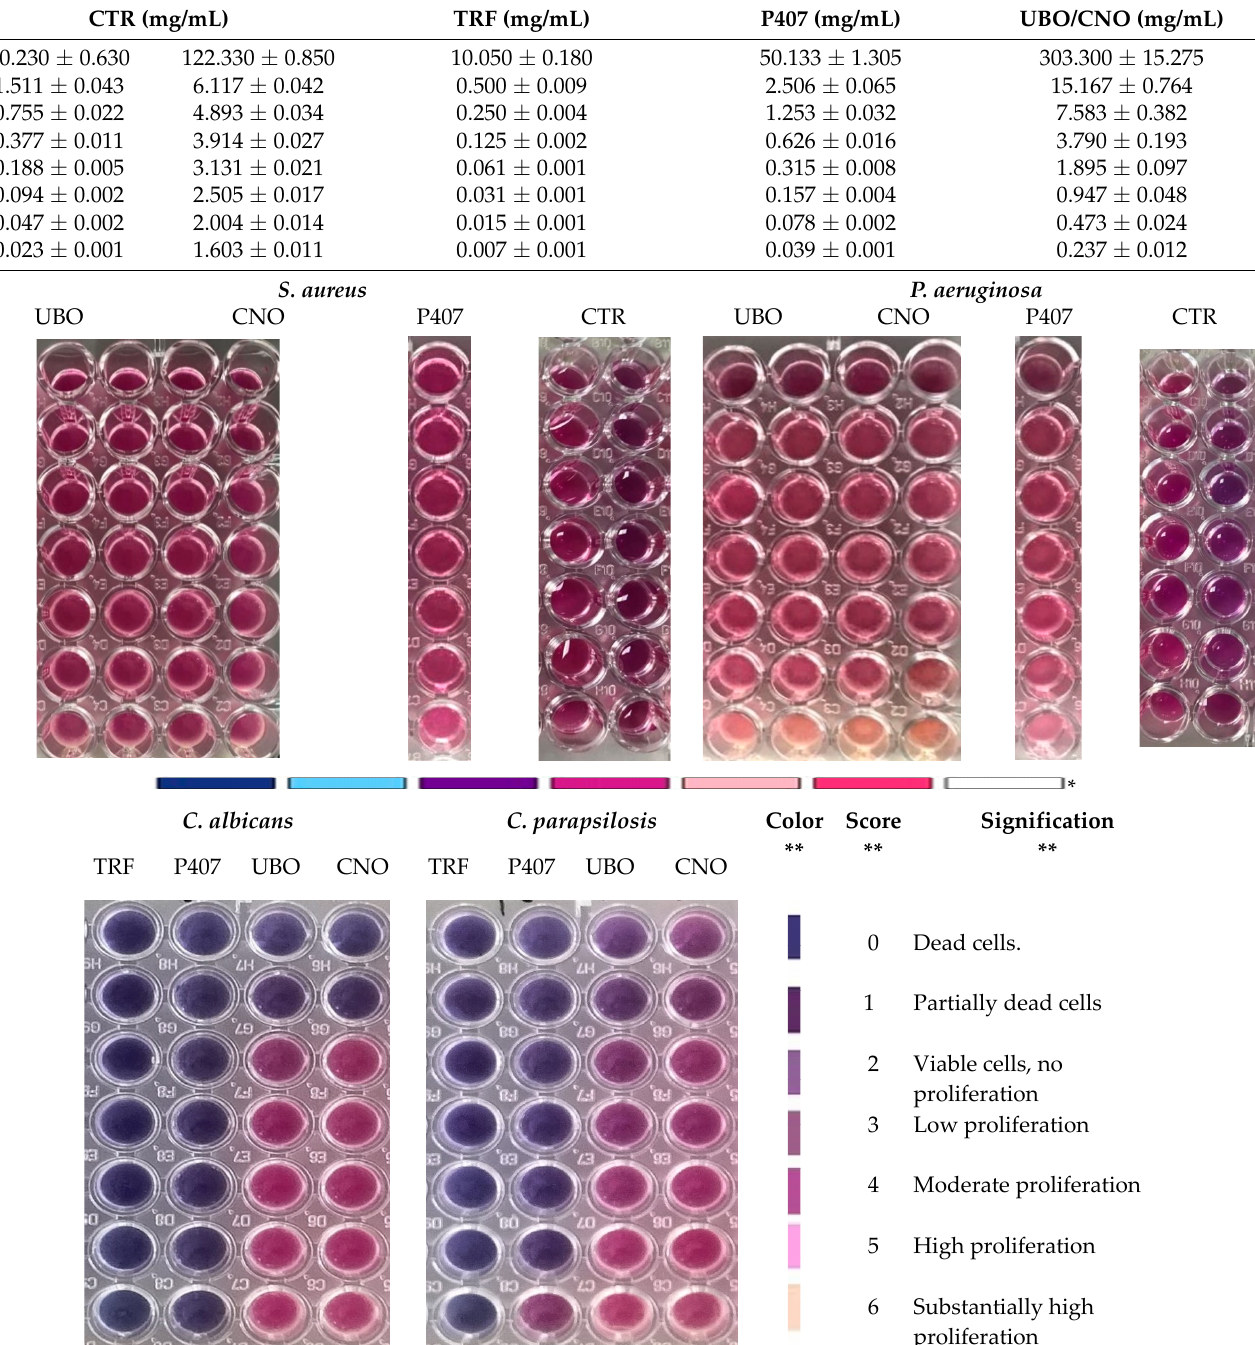
Table 1. Standard antibiotic (CTR), antifungal drug (TRF), Poloxamer 407 (P407), and oil samples (UBO and CNO) microdilutions. The inhibitory activity of oil samples (UBO and CNO) on bacterial species ( S. aureus and P. aeruginosa) and Candida sp. ( C. albicans and C. parapsylosis ); the color score and signification